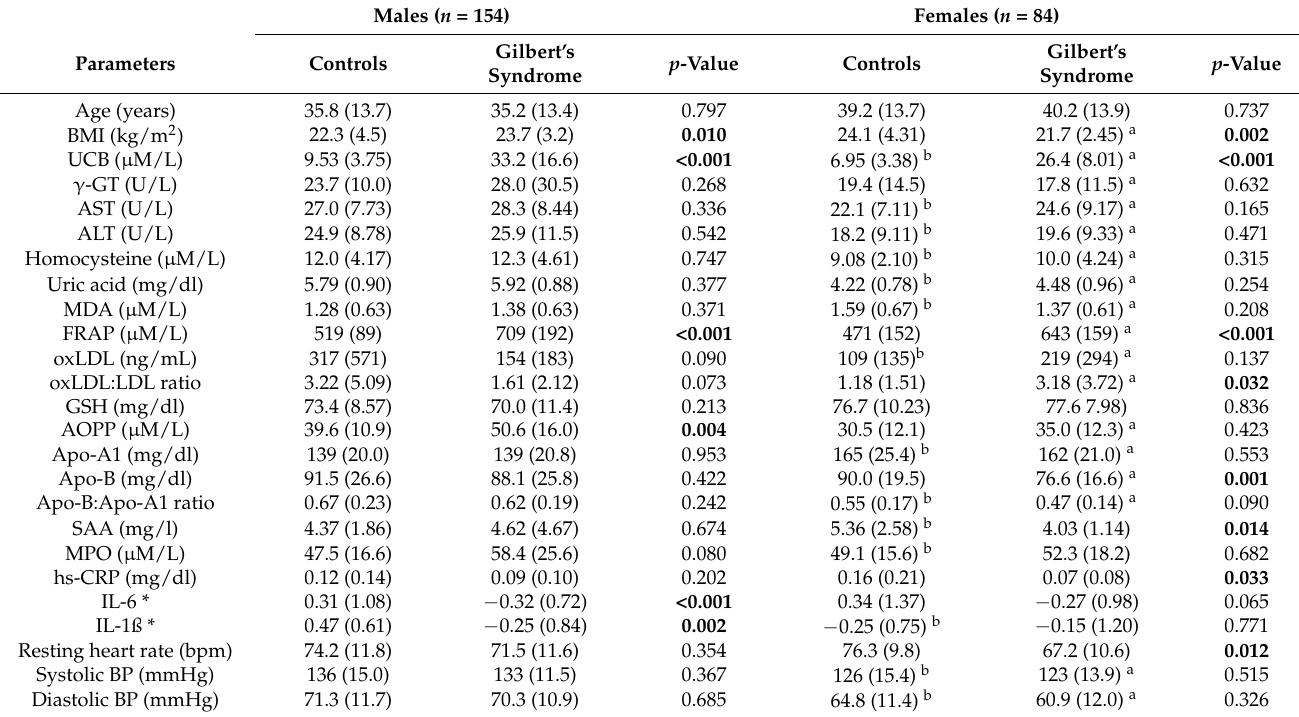
Table 3. Demographic features, biochemical parameters, and biomarkers for oxidative stress and inflammation of individuals with GS and controls according to